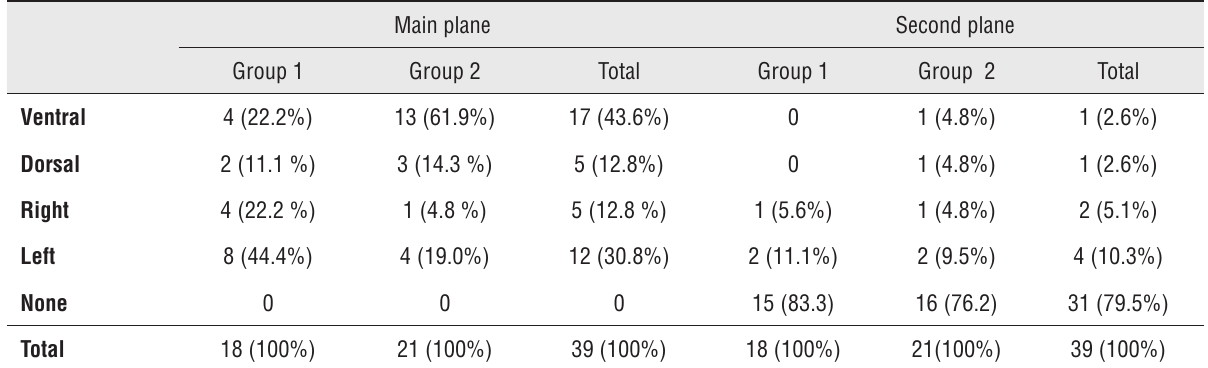
Table 1 - Direction of curvature preoperatively among both groups.